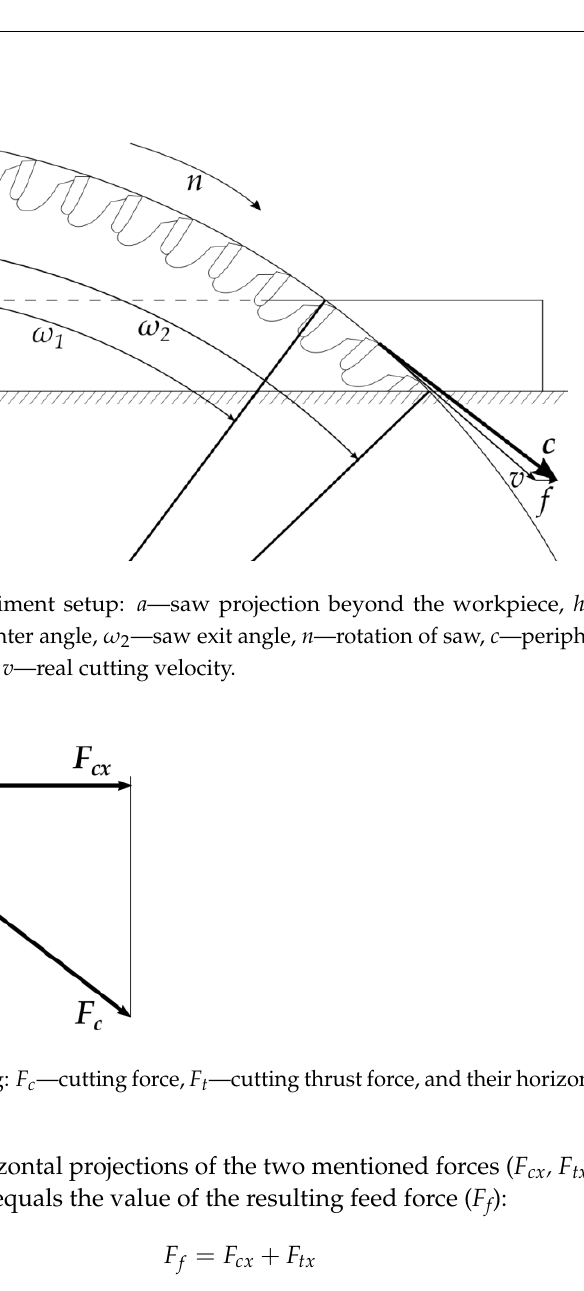
Figure 2. Forces in sawing: F c —cutting force, F t —cutting thrust force, and their horizontal projec- tions: F cx , F tx .